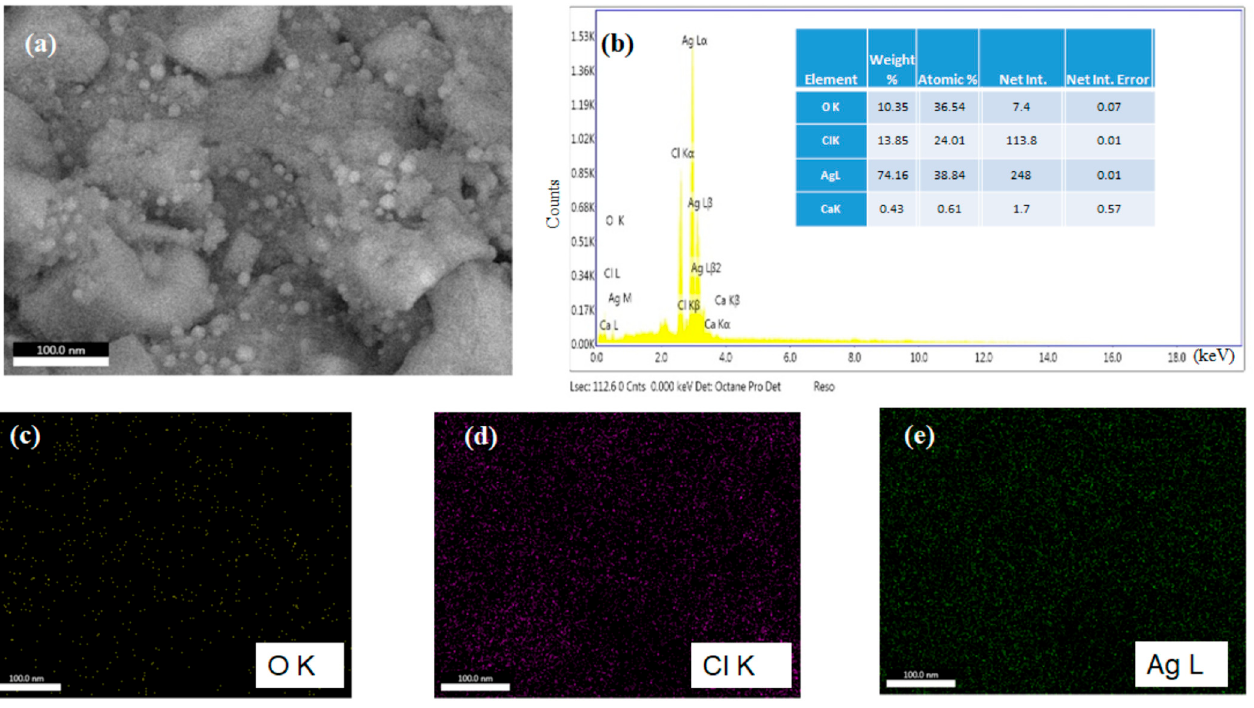
Figure 6. ( a ) SEM, ( b ) EDX of CA-AgNPs.Elemental mapping of CA-AgNP sample, ( c ) O(K) ( d ) Cl (K) and ( e ) Ag (L). (K) and ( e ) Ag